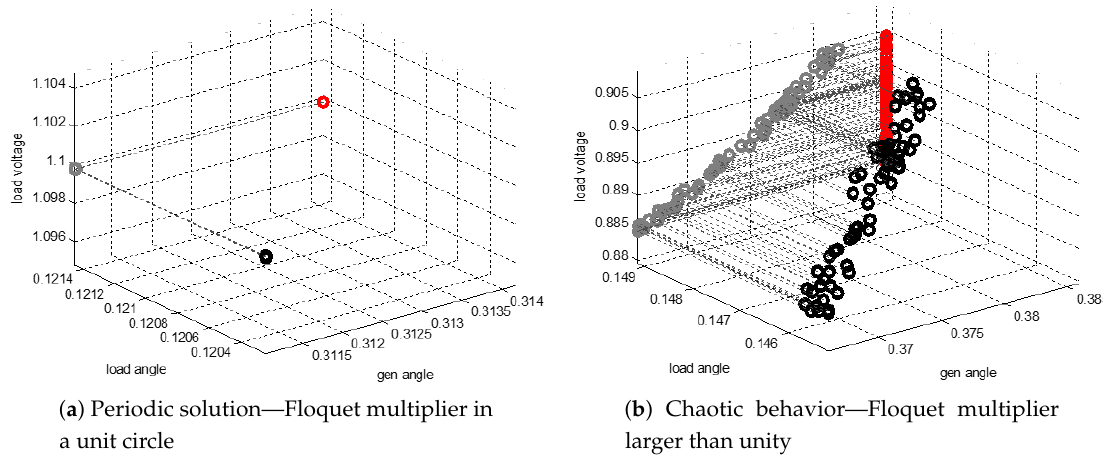
Figure 13. Projection of three-dimensional Poincaré section into load voltage